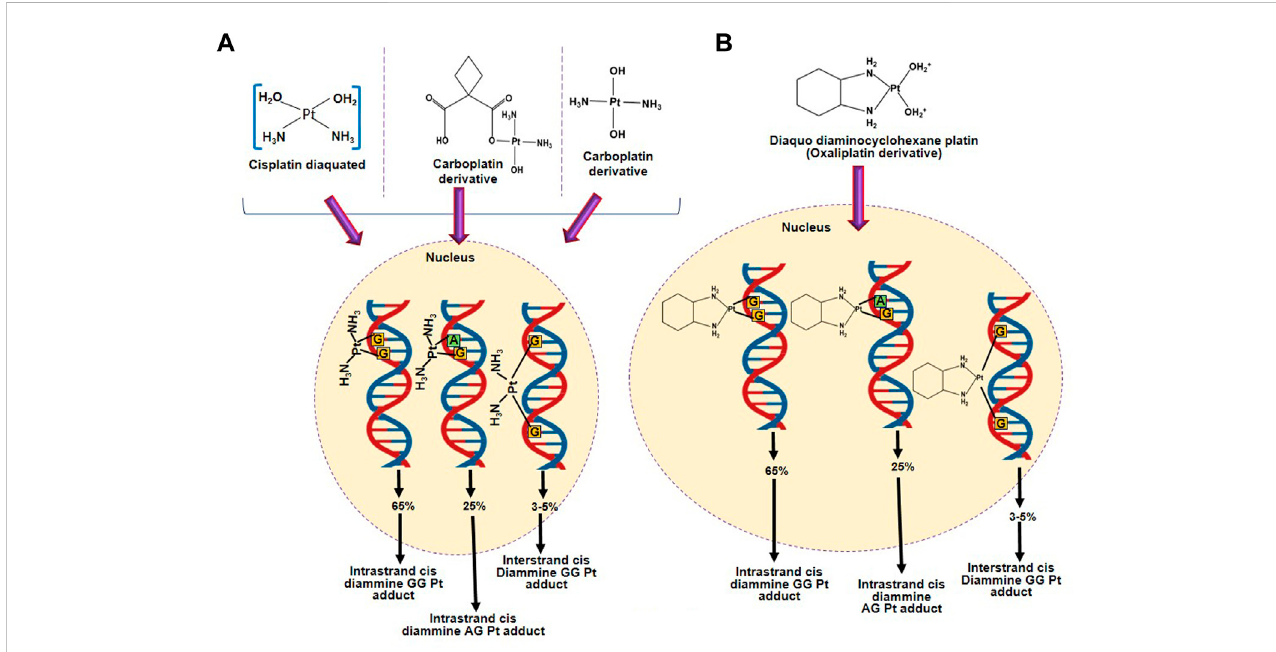
FIGURE 2 Formation of adducts between DNA and platinum-based agents. (A) DNA adduct formation with platinum-based anticancer agents having two amino groups (cisplatin and carboplatin). (B) DNA adduct formation with an active form of